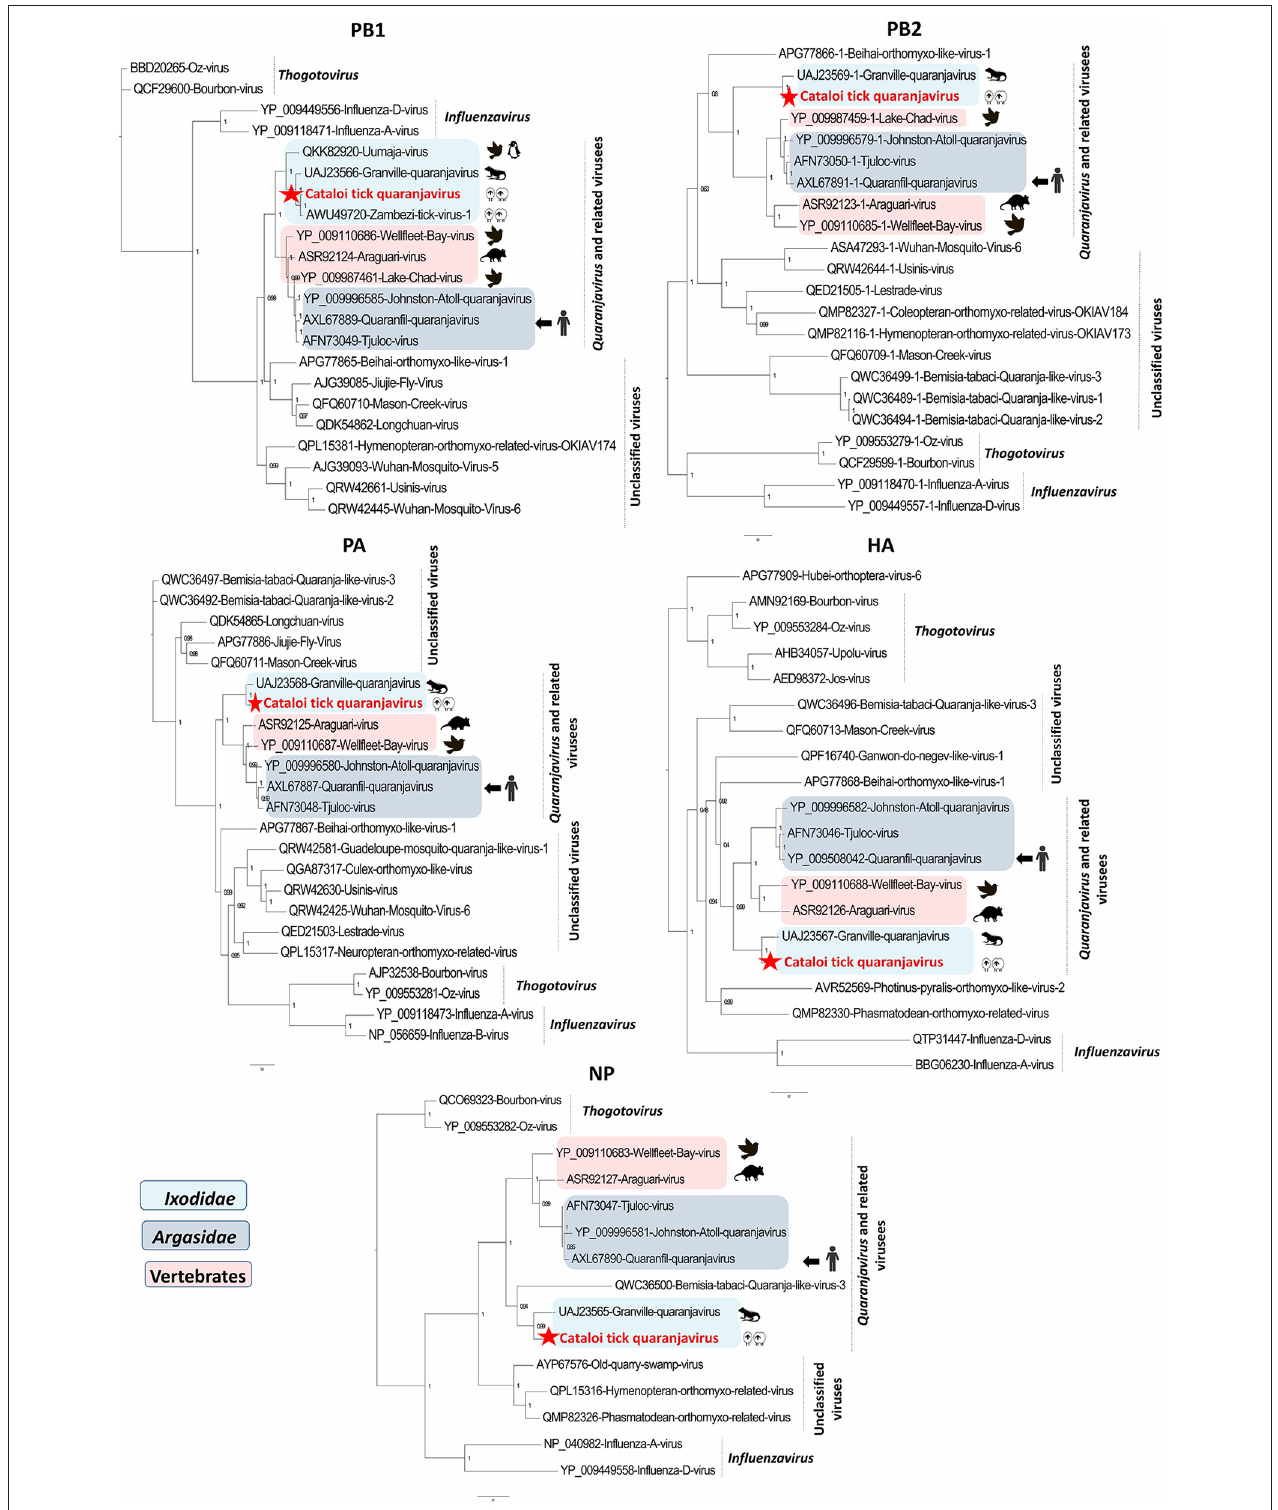
FIGURE 3 | Phylogenetic analysis of Cataloi tick quaranjavirus (CTQV), PB1, PB2, PA, NP, and HA proteins with other viruses in the Orthomyxoviridae family. In light blue: Ixodidae -associated quaranjaviruses; in dark blue: Argasidae -associated quaranjaviruses, in pink: vertebrates associated quaranjaviruses.